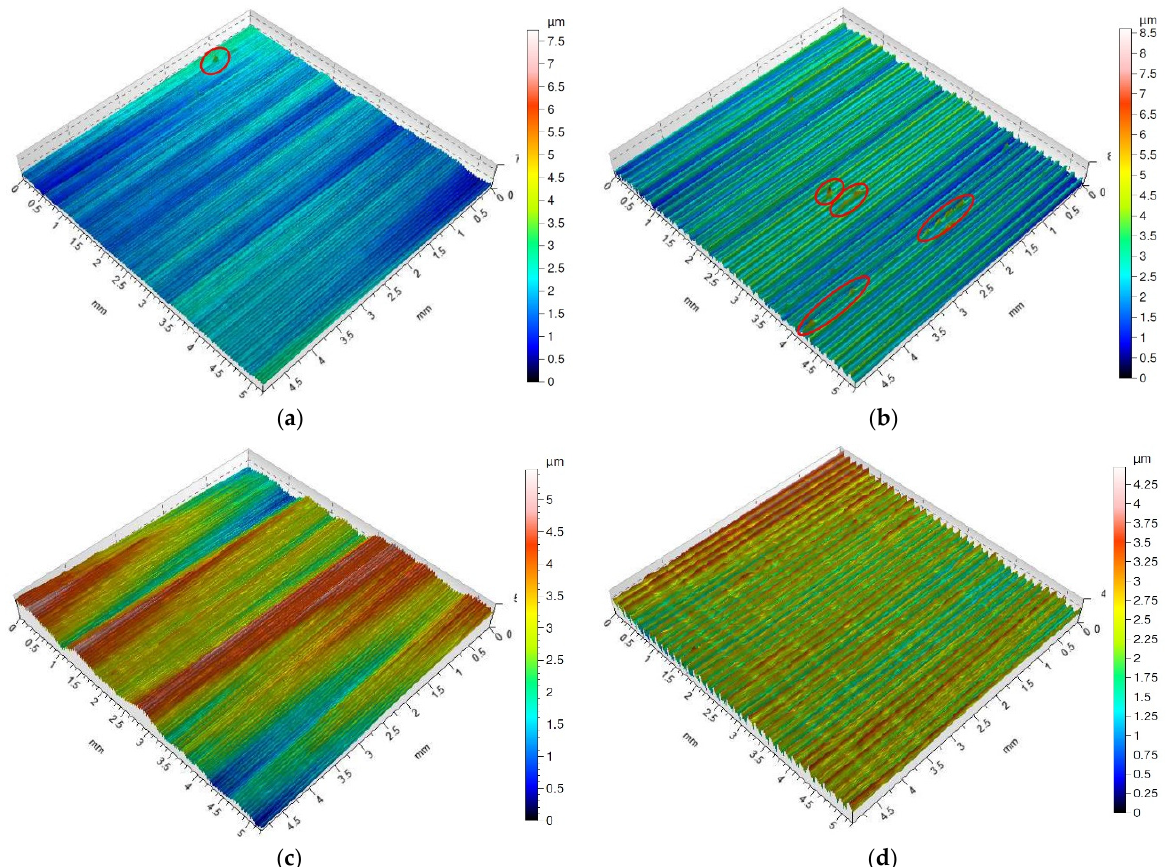
Figure 11. Surface topography of Inconel 718 after turning by the special insert (the sticking on machined surface is marked by red circle). ( a ) dry cutting, f = 0.05 mm/rev; ( b ) dry cutting, f = 0.15 mm/rev; ( c ) wet cutting, f = 0.05 mm/rev; ( d ) wet cutting, f = 0.15 mm/rev.